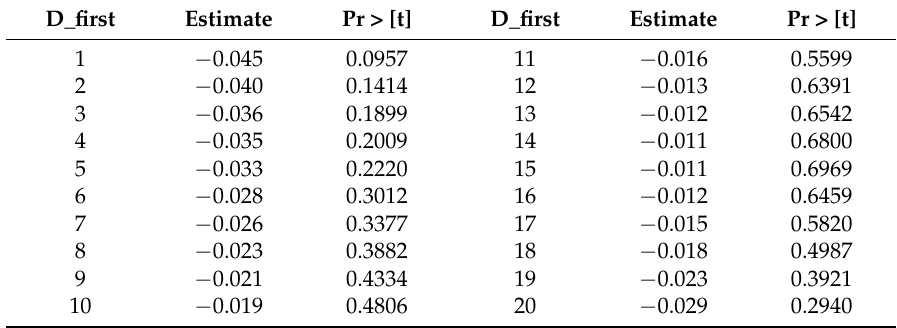
Table 4. Marginal predicted means (m) of D_first effect on DTM adjustment linear mixed